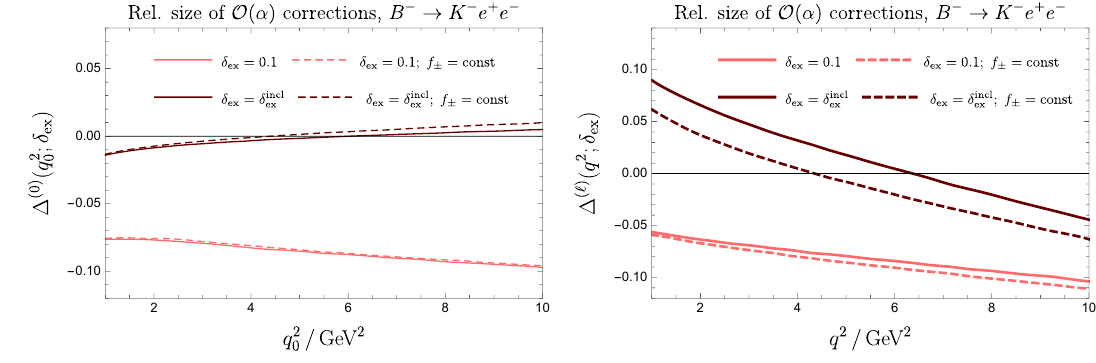
Figure 6 . Plots of total relative QED corrections (4.2) for B − → K − ‘ + ‘ − comparing the constant form factor case versus taking one derivative correction into account with values given in (4.1) (cf. below (2.12) for further comments). Effects are more prominent in the photon-inclusive case ( δ ex = δ inc ) since there is more phase space for the q 2 - and q 2 ex case, we found that the effects are similar albeit slightly